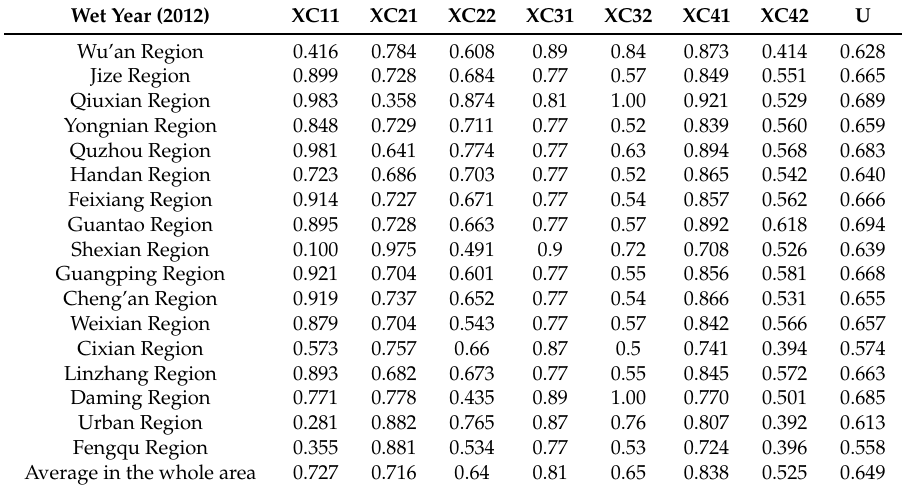
Table 8. Standard values of the second-class indices and the total SWA of different regions in the wet year (2012).